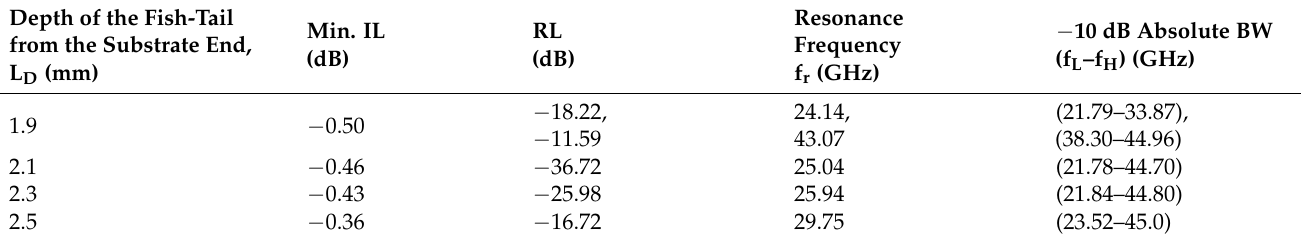
Table 4. Effect of fish-tail depth variations with a fish-tail probe width W P = 3.8 mm.